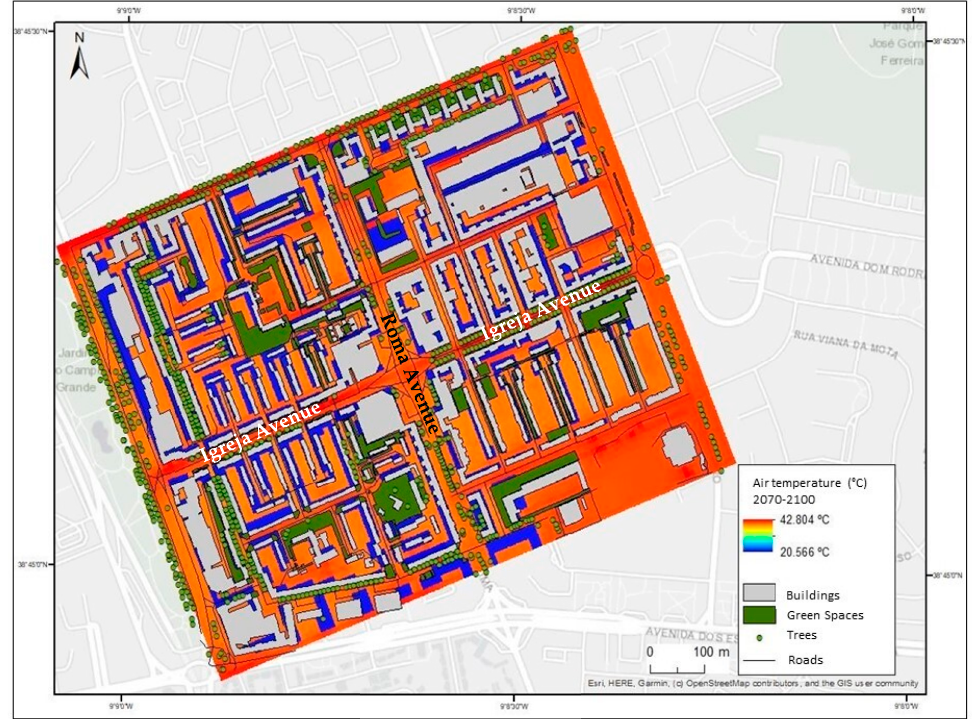
Figure 6. Future model (2070–2100) air temperature, based on IPCC RCP 8.5